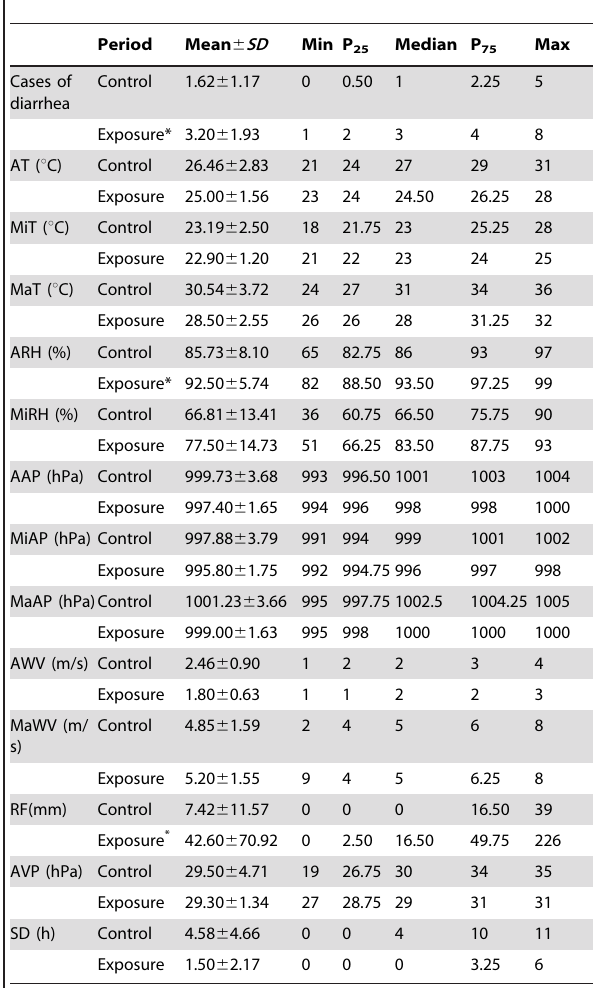
Table 2. Distribution of daily data on cases of infectious diarrhea and meteorological variables in